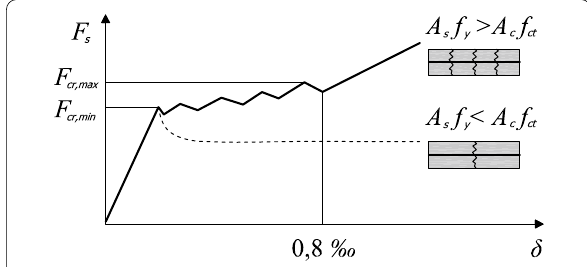
Fig. 4 Relation between imposed strain and tensile force (Krause & Horstmann,